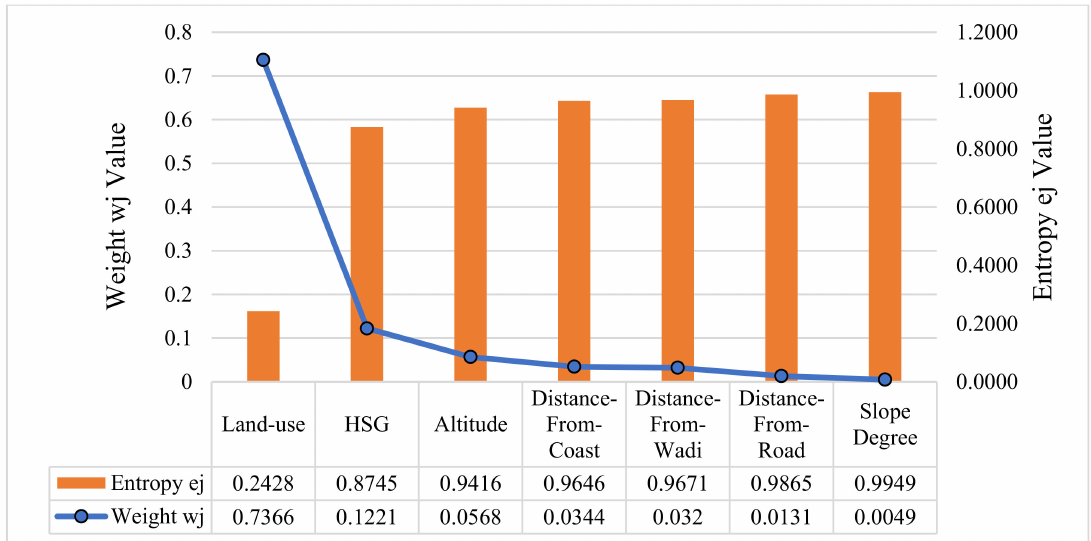
Figure 4. The entropy ( e j ) and weight ( w j ) factor